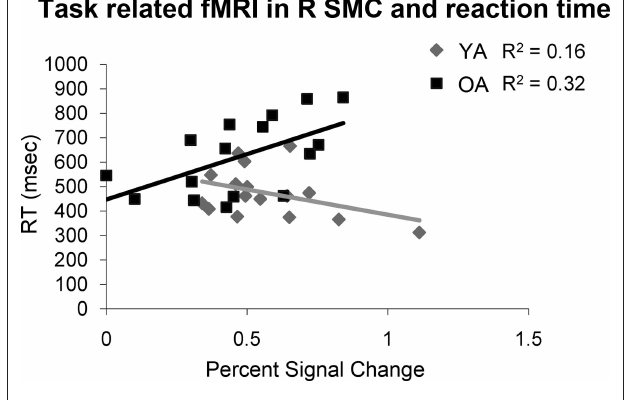
FIguRe 4 | Older adults (OA) demonstrate a significant positive correlation between reaction time and fMRI activation in the right sensorimotor cortex (R SMC) while young adults (YA) do